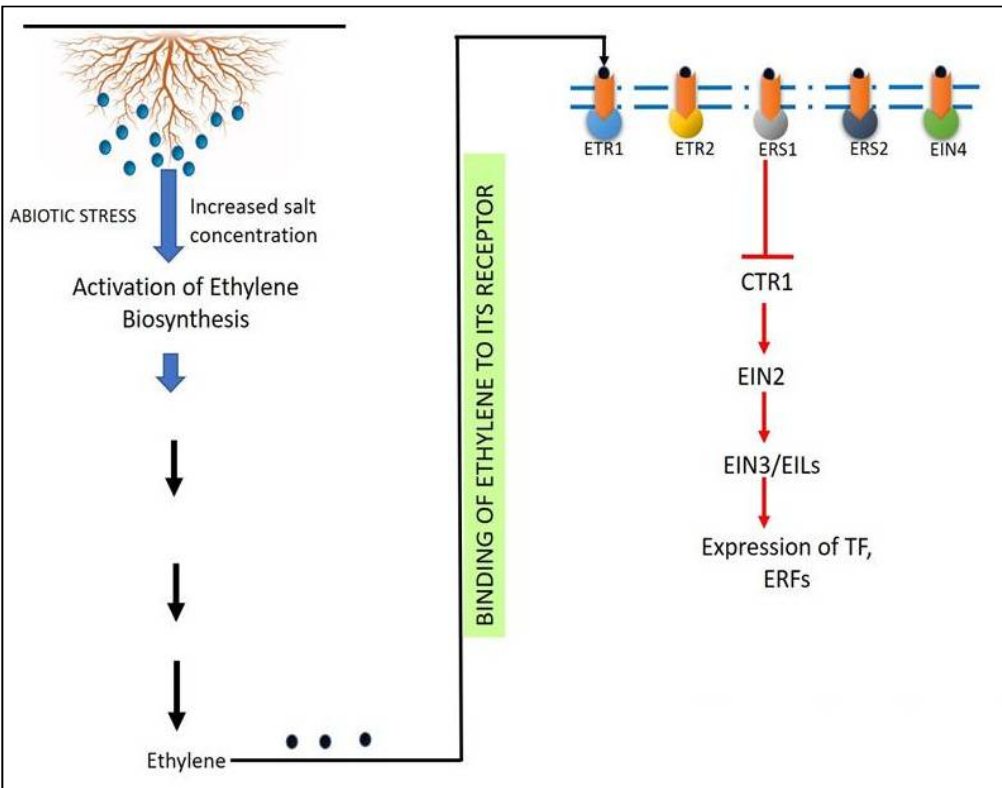
Figure 5. Ethylene signaling pathway under abiotic stress.